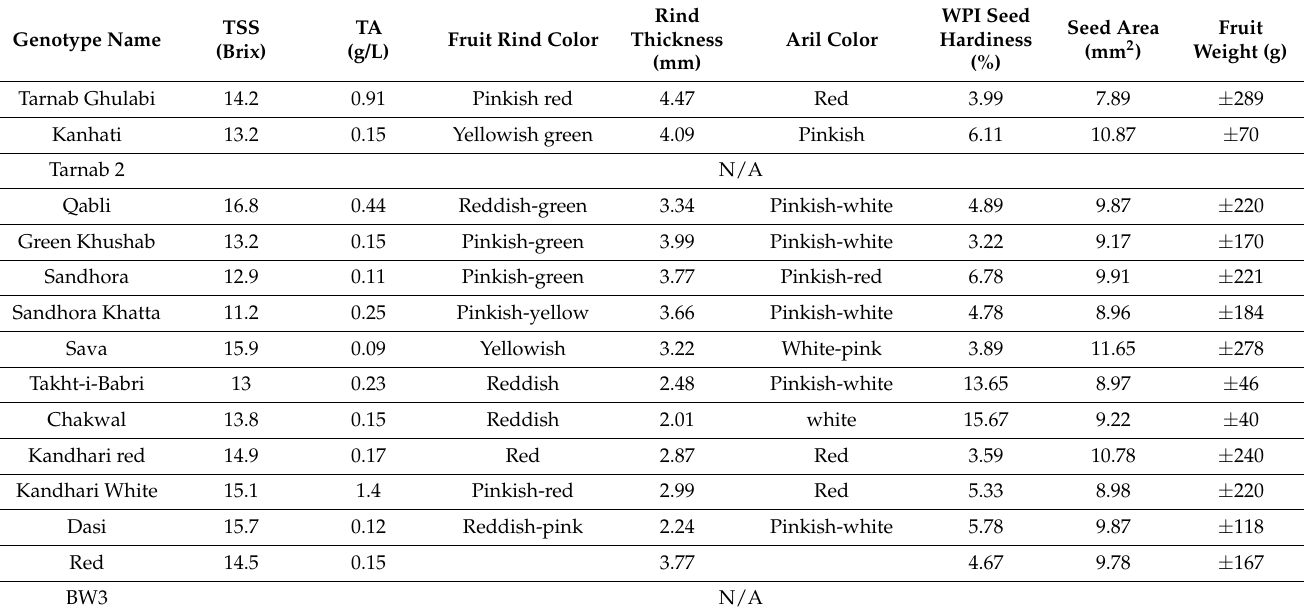
Table 3. Characteristics of pomegranate germplasm used for experiment